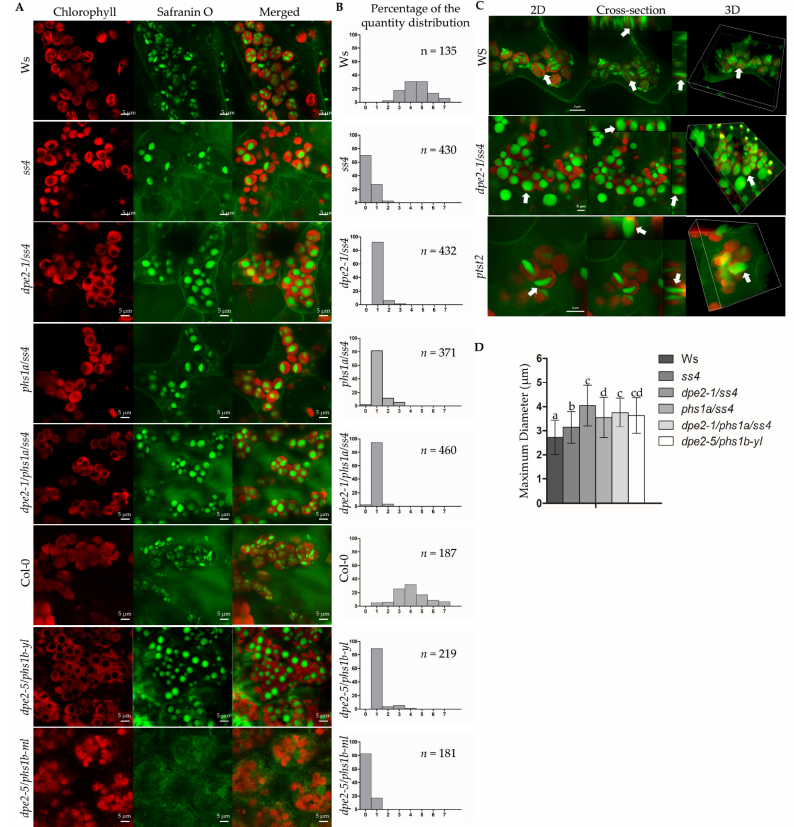
Figure 1. Starch granules in mesophyll cells. ( A ) Graphs were taken from 3-week-old rosette leaves of wild types and mutants. All samples were taken in the middle of the light phase. Dpe2-5/phs1b accession is Col-0; yl, young leaves and ml, mature leaves. Scale bar is equivalent to 5 µ m. ( B ) The quantity distribution of the starch granules per chloroplast in the mesophyll cells. ( C ) The 2D, cross-section, and 3D views of the starch granules isolated from Ws, dpe2-1/ss4 , and ptst2 . Scale bar as indicated. ( D ) Diameters of the starch granules in the mesophyll cells, measured by ZEN 2 lite software, n > 80. The mean and SD are shown. Letters indicate statistically significant differences ( p ≤ 0.05) according to the one-way ANOVA with Tukey’s post-hoc